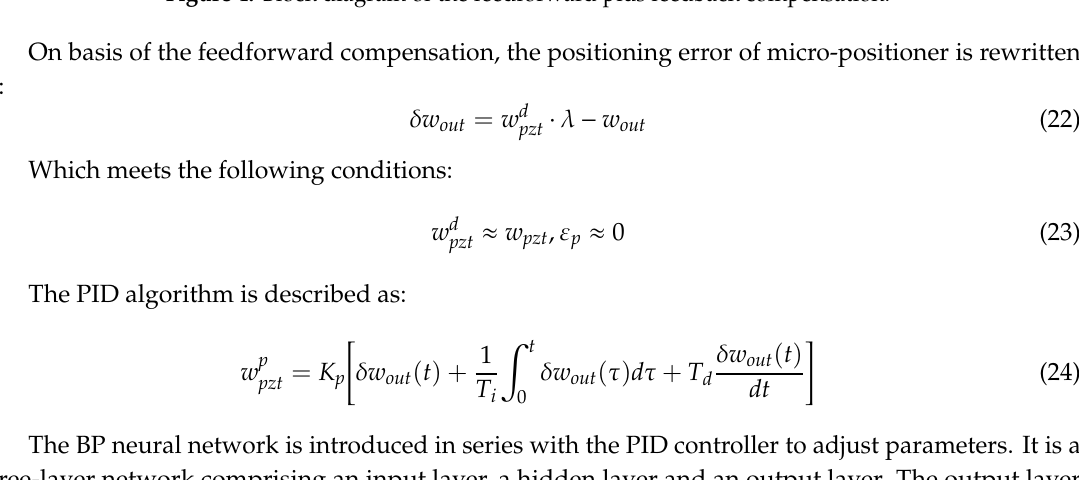
algorithm permits a more e ff ective weight updating procedure for infinite approximation of a